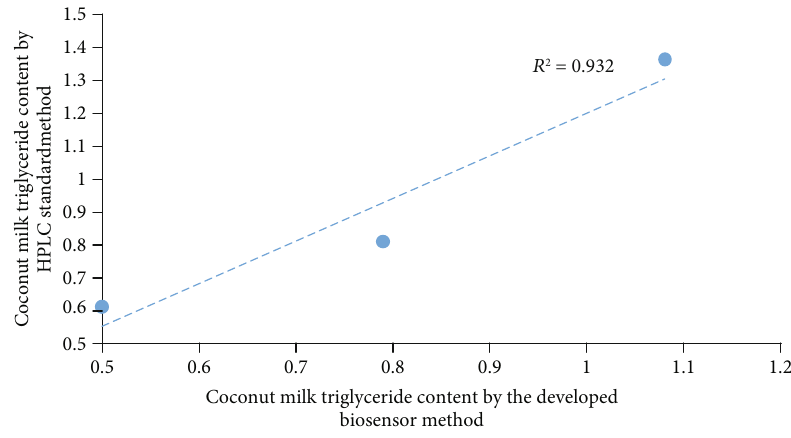
Figure 7: Correlation between the developed biosensor method and the standard HPLC